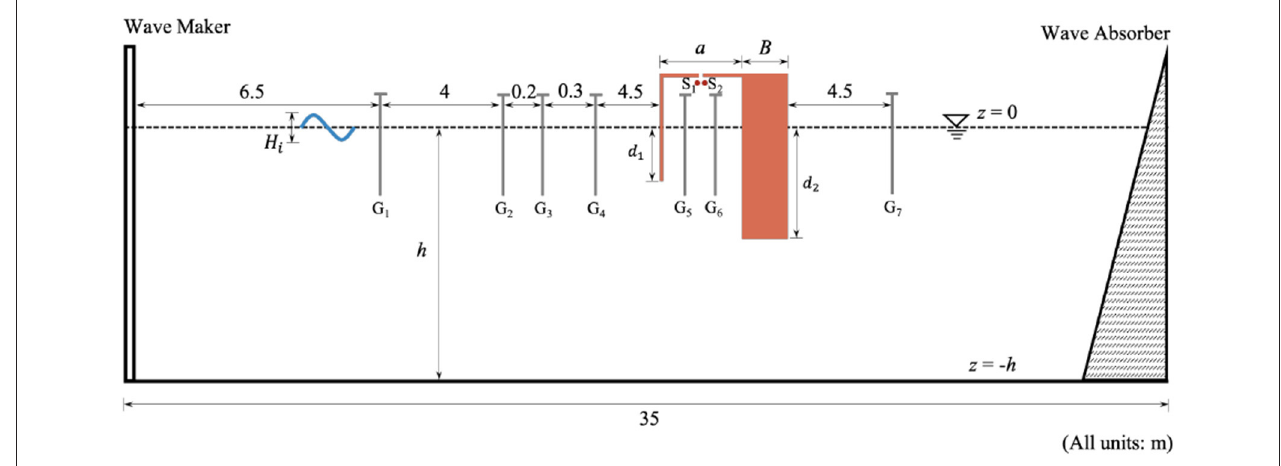
FIGURE 2 | Experiment layout.